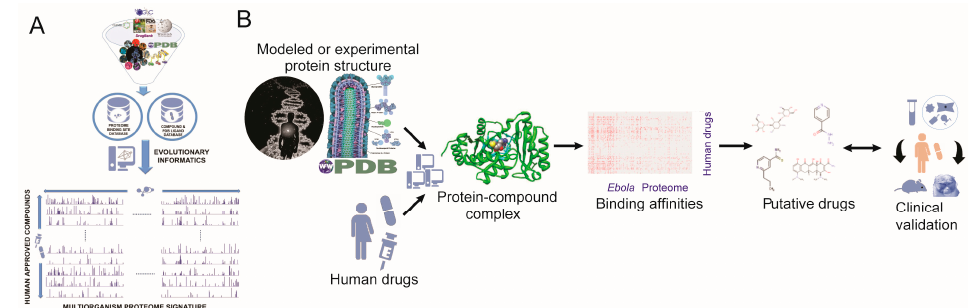
Figure 1. The Computational Analysis of Novel Drug Opportunities (CANDO) platform as applied to five Ebola proteomes. ( A ) General version of the platform used to determine drug behavior and protein structures; ( B ) CANDO platform as applied to Ebola, where the known drugs are docked to structures of five Ebola proteomes to identify the strongest multitarget inhibitors. Credit: Vignettes derived from Protein Data Bank (PDB) structures depicting Ebola virus glycoprotein, matrix protein, nucleoprotein, and nucleocapsid proteins (PDB identifiers 3csy, 4ldd, 4qb0 and 2i8b, 3vne, 3fke respectively).